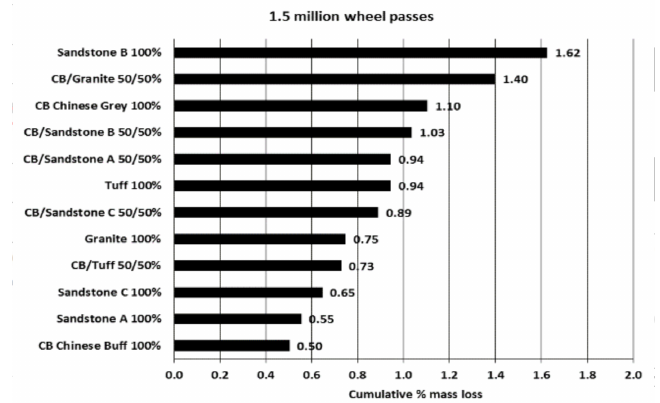
Figure 5. Percentage mass loss ranking after 1.5 million wheel-passes (Aetec